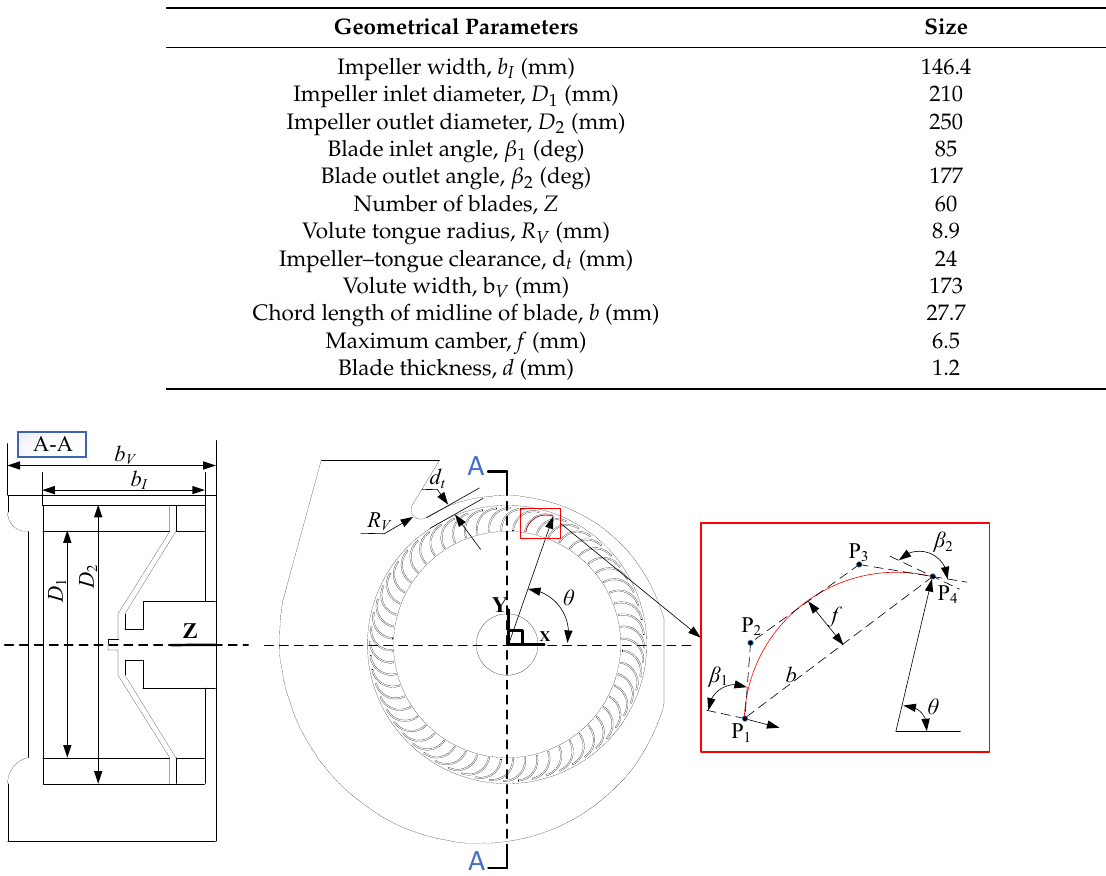
Figure 3. Geometric parameters of squirrel-cage fan. Compared with a single arc, the spline curve has a more flexible and complex shape, Table 1. Geometrical parameters of the squirrel-cage fan. one that is widely used in fan blade design [26]. Concerning the parametric description of the blades in the axial flow fan [27], we used the B-spline curve to control the shape of the blades. In blade parameterization, the center of the impeller rotation axis was taken as